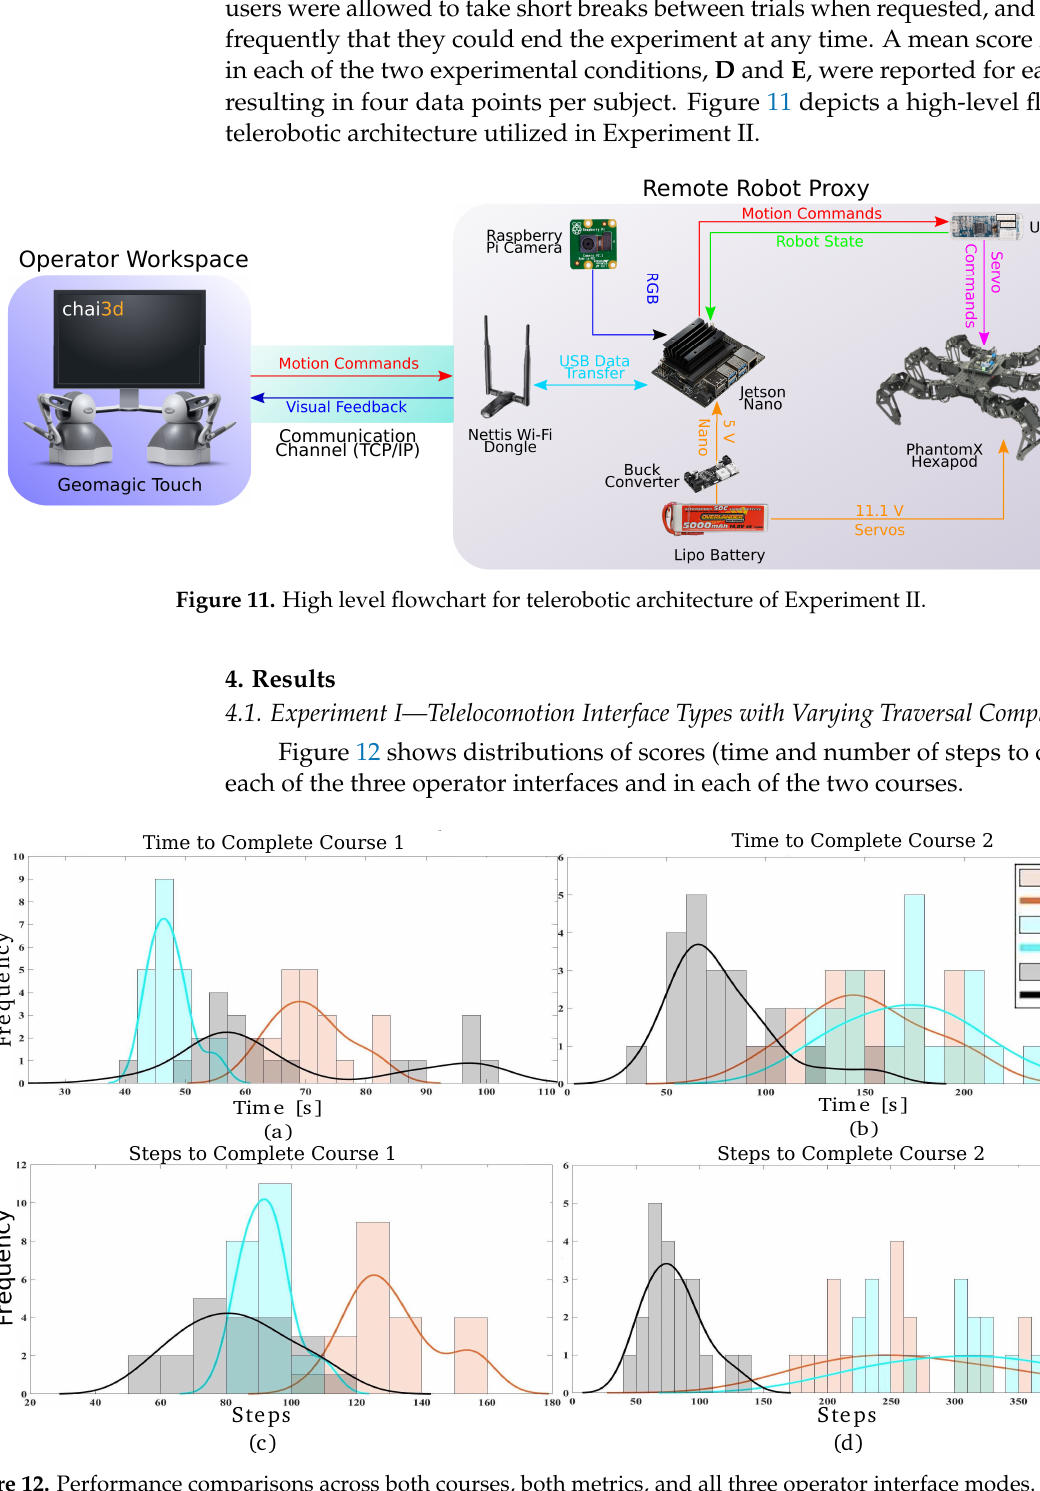
Figure 12. Performance comparisons across both courses, both metrics, and all three operator interface modes. ( a ) time for flat, ( b ) time for stairs, ( c ) steps for flat ( d ) steps for stairs. Pink indicates K , blue indicates J , gray indicates H